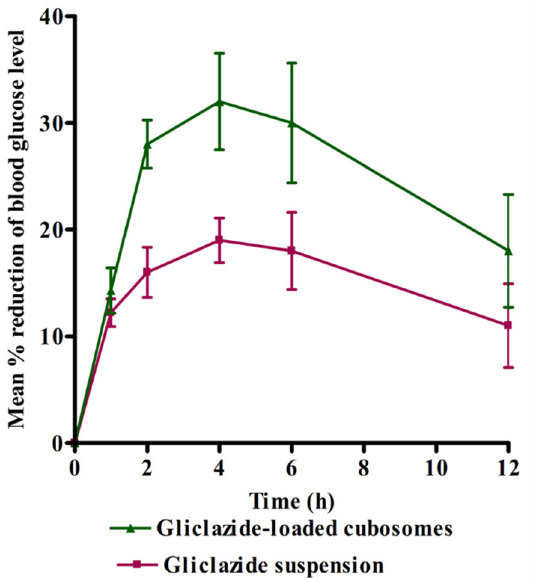
Figure 6. Mean (n = 6 ± SD) % reduction in blood glucose level of diabetic rats after the administra- tion of a single oral dose (10 mg/kg) of gliclazide-loaded cubosomal nanoparticles and drug suspen- sion to diabetic